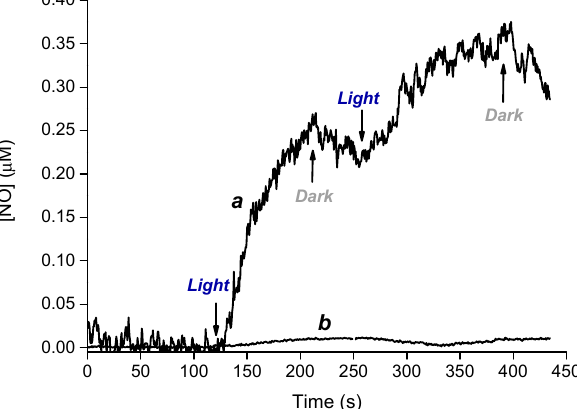
Figure 2. NO release profile observed upon irradiation at 405 nm (100 mW) of CL loaded ( a ) and unloaded ( b ) with compound 1 and immersed in 3 mL of artificial tears solution.